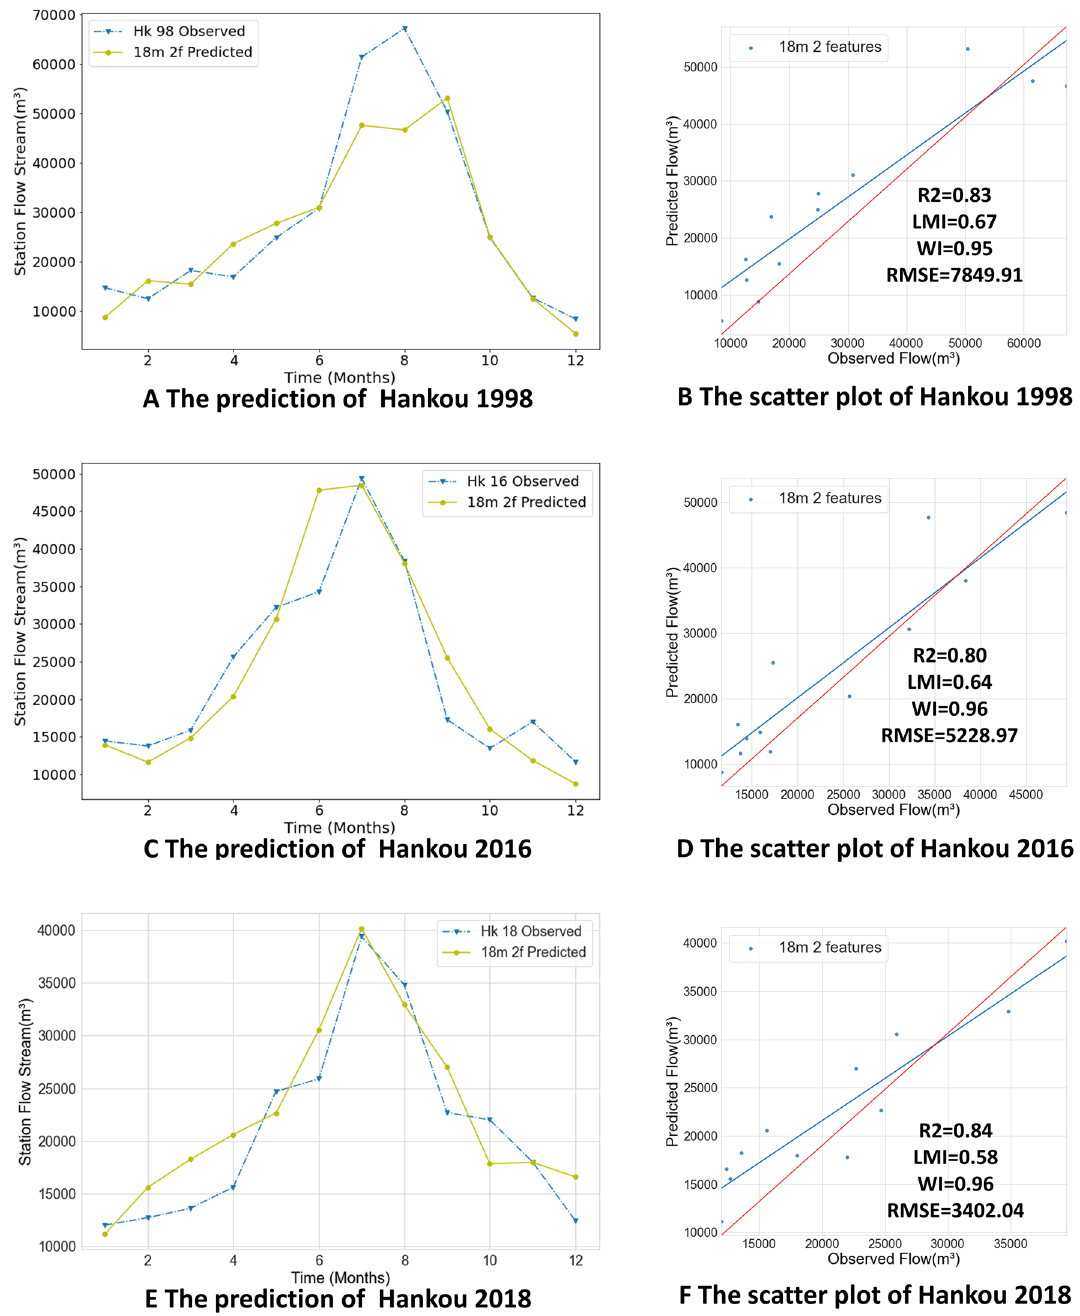
Figure 10. The result of Hankou Station. ( A, C, E ) Line plots of predicted and observed values. The blue dashed line represents the observed values. The green solid line are predicted values. ( B, D, F ) Scatter plots of predicted